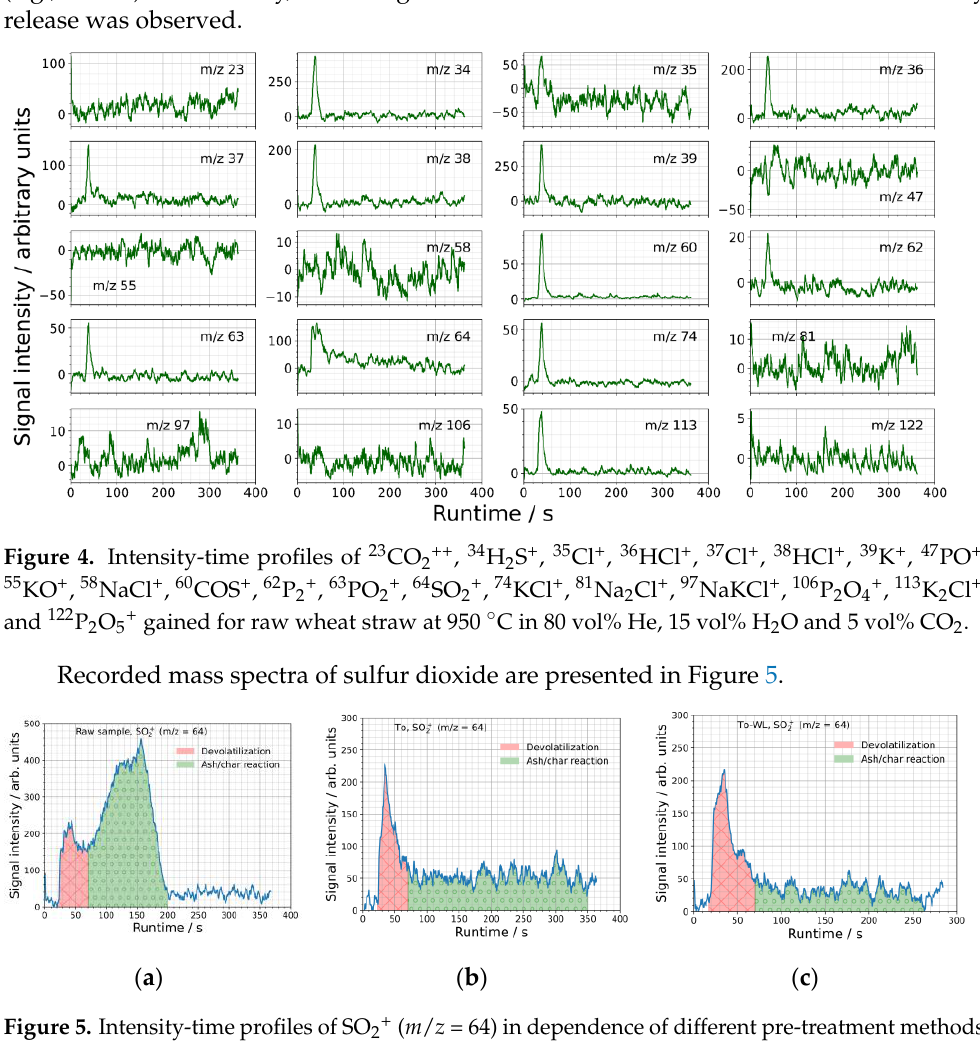
Figure 5. Intensity-time profiles of SO 2+ ( m / z = 64) in dependence of different pre-treatment methods. Raw wheat straw sample ( a ), torrefied sample ( b ), and (i) torrefied, then (ii) water-leached sample ( c ). The intensity-time profiles exemplify the effect of the applied pre-treatments. The torrefied and subsequently water-leached sample shows almost no more char gasification/ash reaction ( c ).